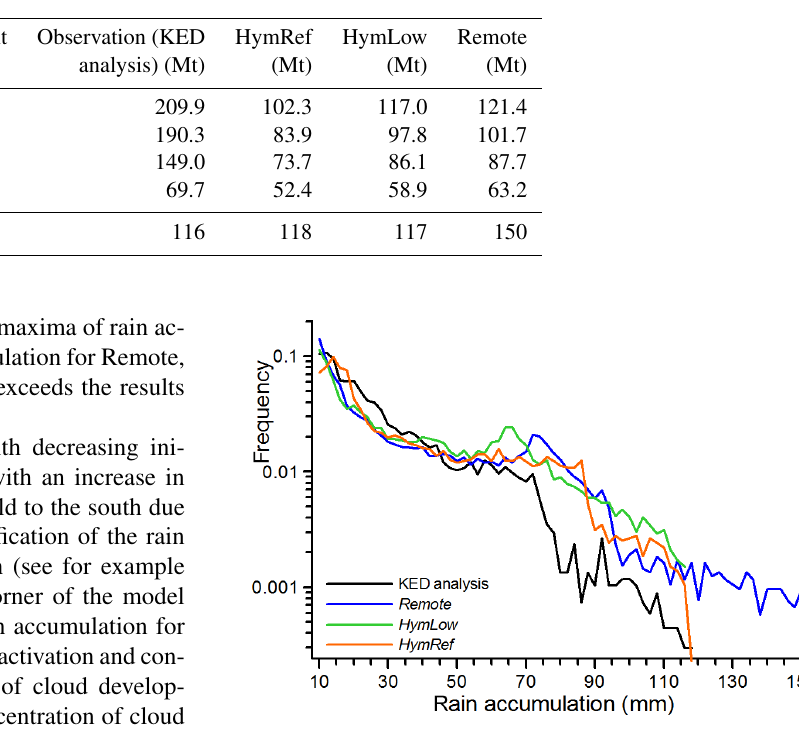
Figure 9. Normalized occurrence of observed and simulated rain accumulation from 06:00 to 11:00UTC. The bin size for the rain accumulation is 2mm. Note the logarithmic frequency